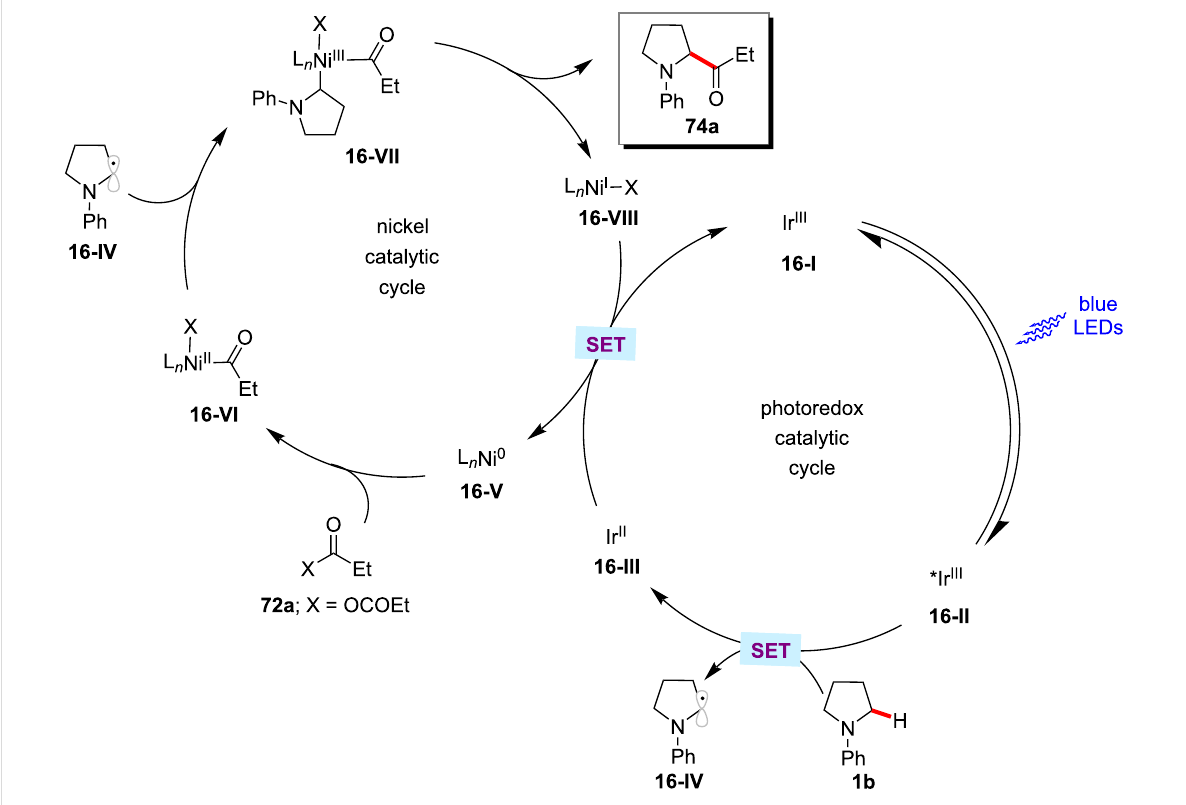
Figure 16: Proposed mechanism for the photoredox nickel-catalyzed acylation of α -amino C(sp 3 )–H bonds of N -arylamines.